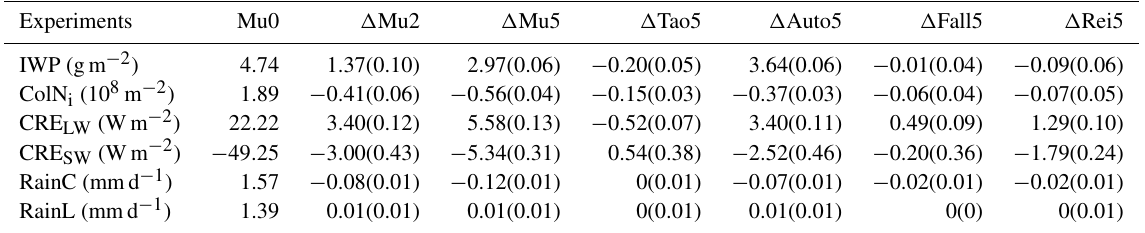
Figure 3. Similar to Fig. 2 but for the (cid:49) Tao5, (cid:49) Auto5, (cid:49) Fall5, and (cid:49) Rei5 experiments. Except for the R Rei5 e calculated with µ i = 0. Table 4. The global annual mean variables are shown in Fig. 4. The corresponding standard deviations calculated from the difference of each year for 10 years are shown in